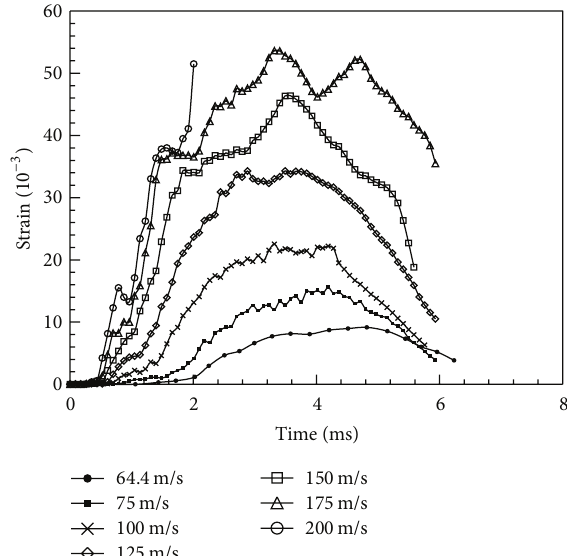
Figure 13: Displacement time plot at Location 4.